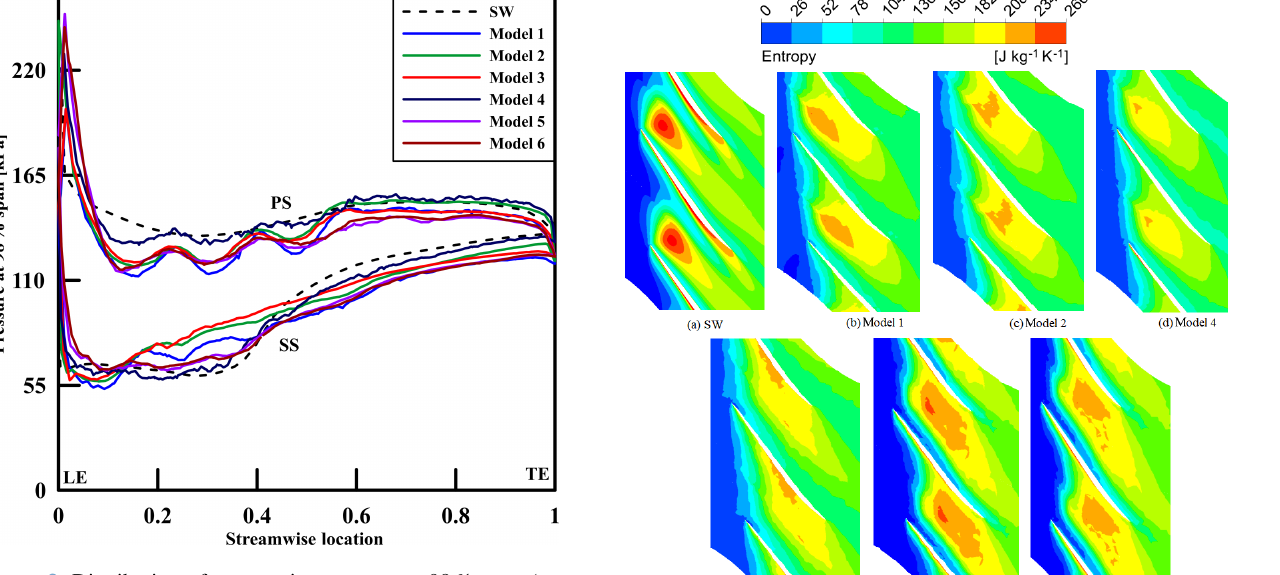
Figure 6. Distribution of streamwise pressure at 98% span (near stall condition) for smooth casing and all models.